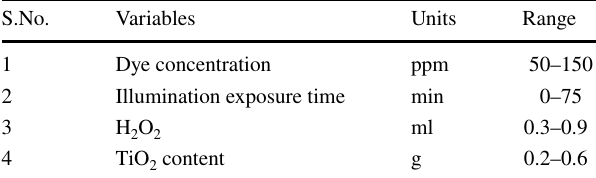
Table 5 Studied variables in the RSM modeling